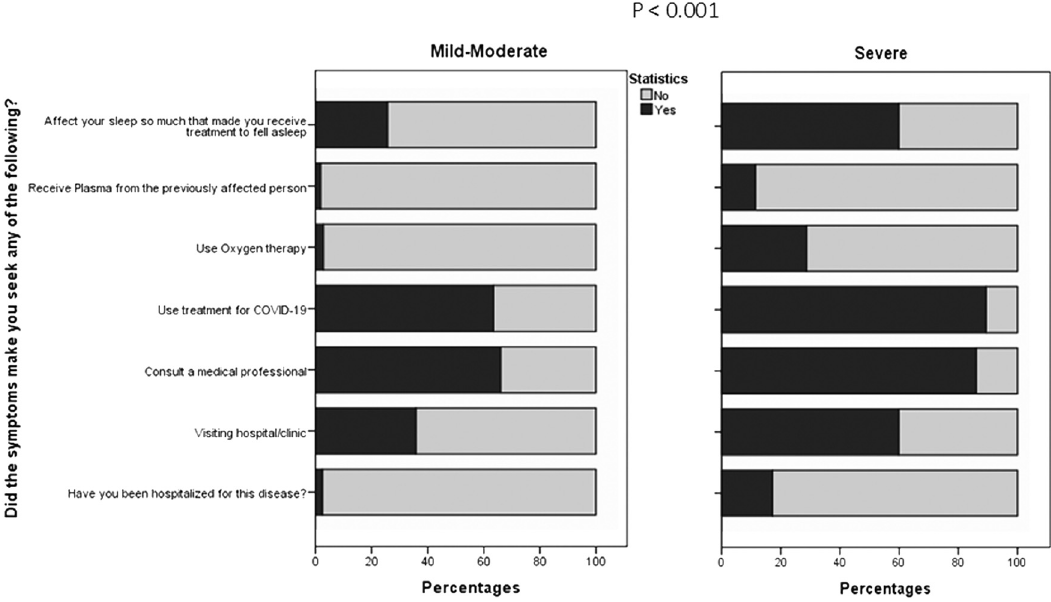
Figure A1: Comparison of the severity parameter - II data in between the mild - moderate and severe groups.